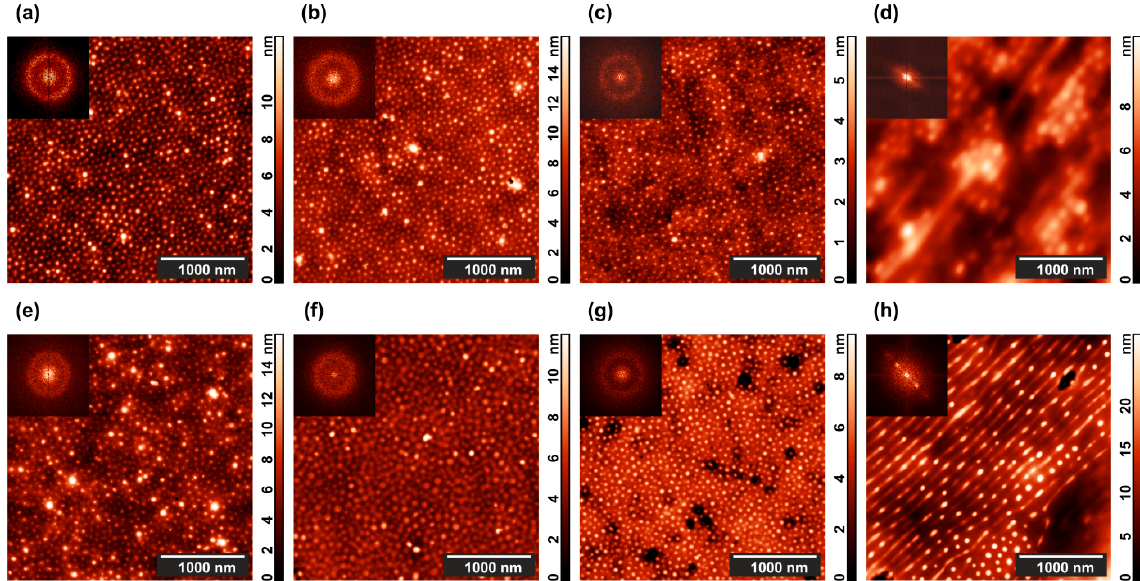
Figure 2. Typical AFM images of microphase-separated (top row) PS–P4VP copolymer and (bottom row) PS–P4VP/AuNR composite films after 24 h annealing in ( a , c , e , g ) 1,4-dioxane and ( b , f , d , h ) chloroform vapor ( a , b , e , f ) without and ( c , d , g , h ) with 800 V DC electric field. Two-dimensional (2D) Fourier transforms of the corresponding topographies are shown in the insets.